Question: Briefly state, in one sentence, what is plotted here.
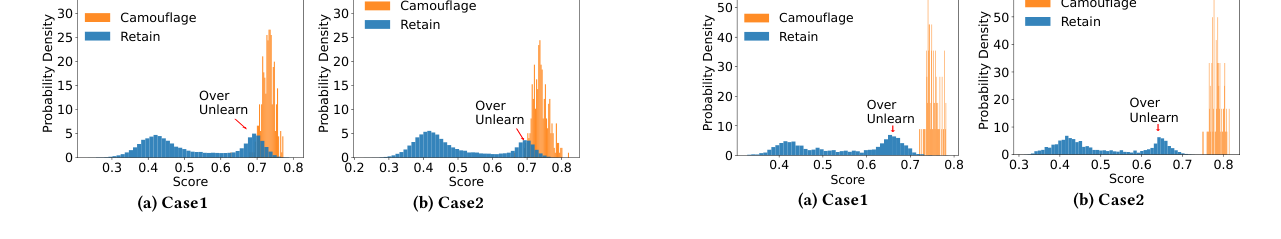
Answer: , 19, 20, and 21 report the measurement results of Un- leScore for the camouflage unlearning case across four additional datasets. These results demonstrate smaller differences between case1 and case2 compared to those in CIFAR10, likely due to the